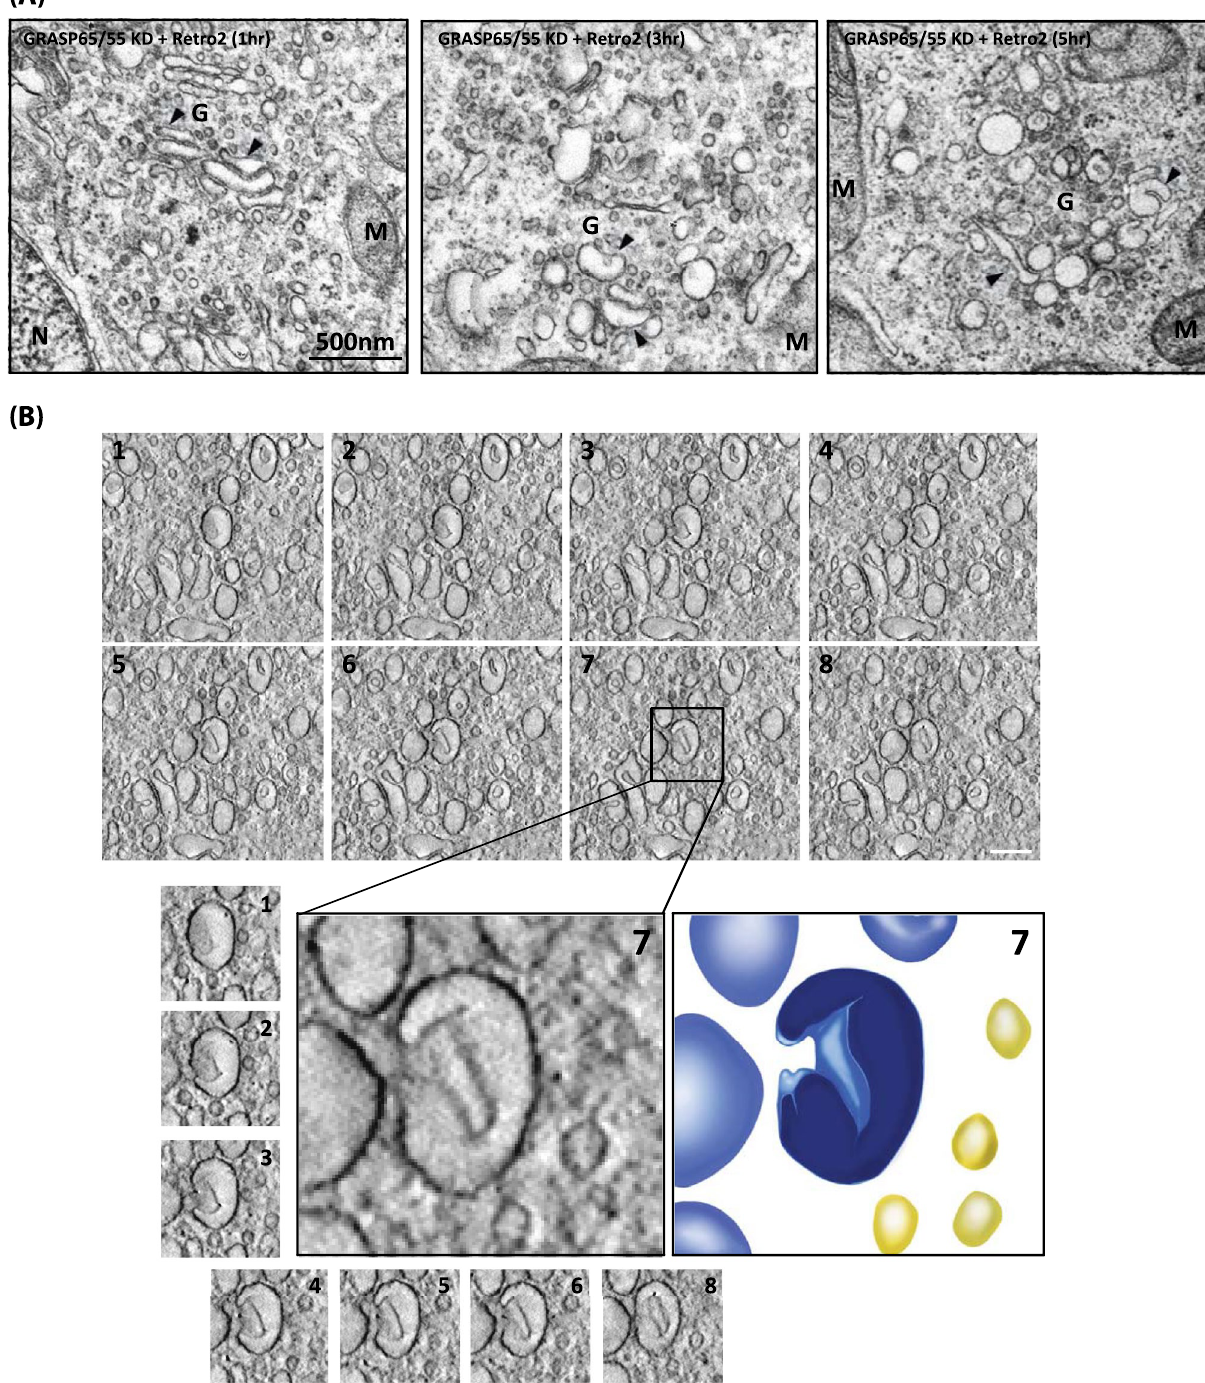
Figure 5. Retro-2-induced Golgi unstacking in GRASP65/55-depleted HeLa cells occurs in a time-dependent manner. ( A ) Representative EM micrographs showing that Golgi unstacking by Retro-2 treatment in GRASP65/55-depleted cells is a time-dependent process. These images show morphological and structural changes of the Golgi in GRASP65/55-depleted HeLa cells after Retro-2 treatment for 1, 3, 5 h, respectively. Black arrow heads indicate Golgi cisternal membranes during Retro-2-induced Golgi unstacking (scale bar 500 nm). ( B ) Sequential slice views from the tomogram showing more detailed structures of the ‘cup’-shaped, unstacked cisternal membranes. Below are the magnified views and segmentation of rendition from one of the unstacked cisternae (light blue; yellow indicates vesicular profiles in peri-Golgi area). (scale bar 200 nm). See movie#S1 for more